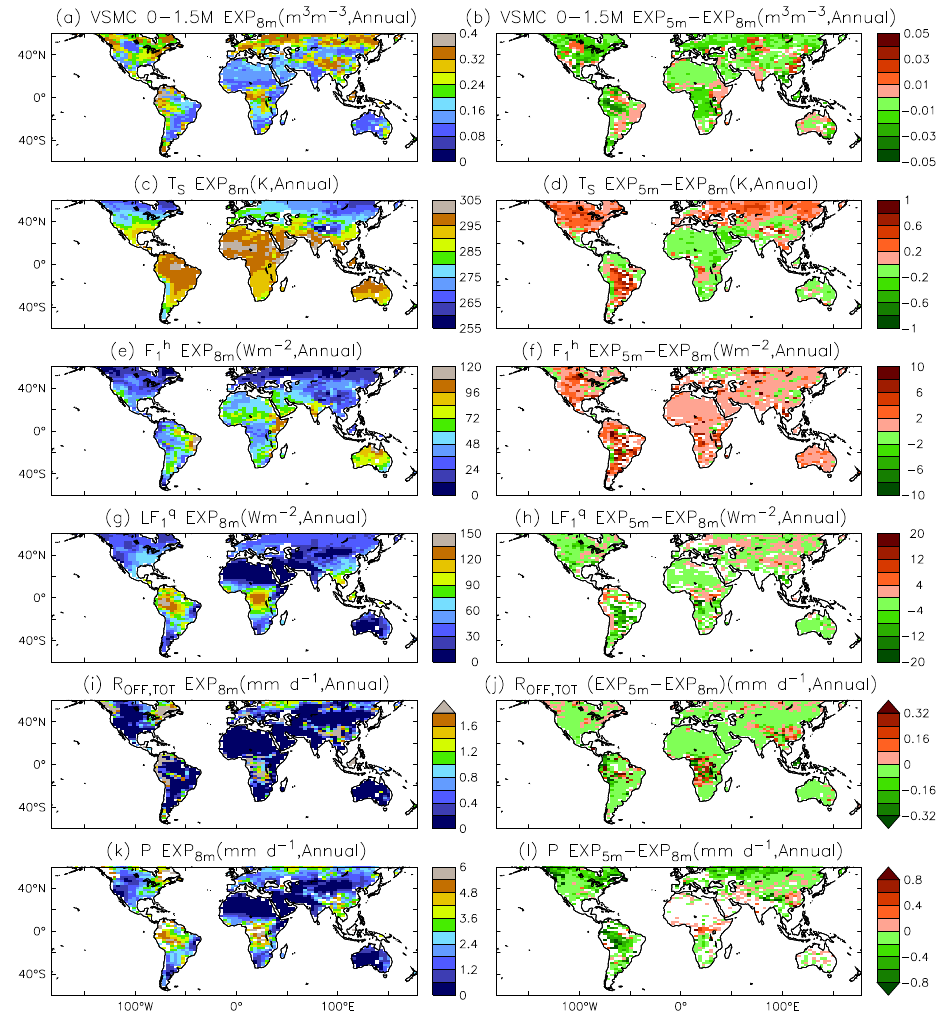
Figure 5. The results of EXP 8m (8M17L, left) and the difference between EXP 5m (5M7L, Table 4) and EXP 8m (right): (a, b) volumetric soil moisture content at 0–1.5m, (c, d) surface temperature T S , (e, f) sensible heat flux F h R OFF , TOT , and (k, l) precipitation P .